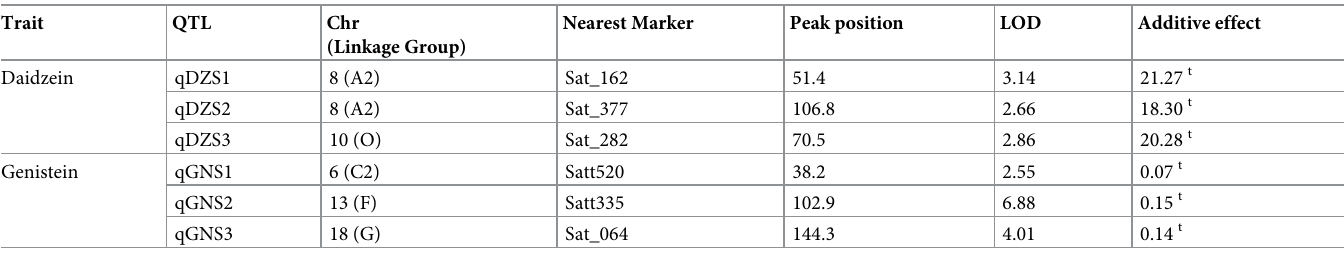
Table 3. Identified QTLs controlling daidzein and genistein secretions from roots detected by means of composite interval mapping in the PT-RIL population.